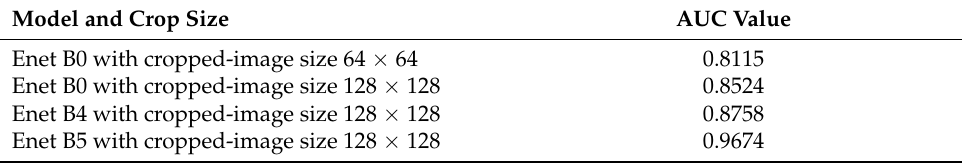
Table 1. Testing AUC values of models trained with different EfficientNet and cropped-image size. Model and Crop Size